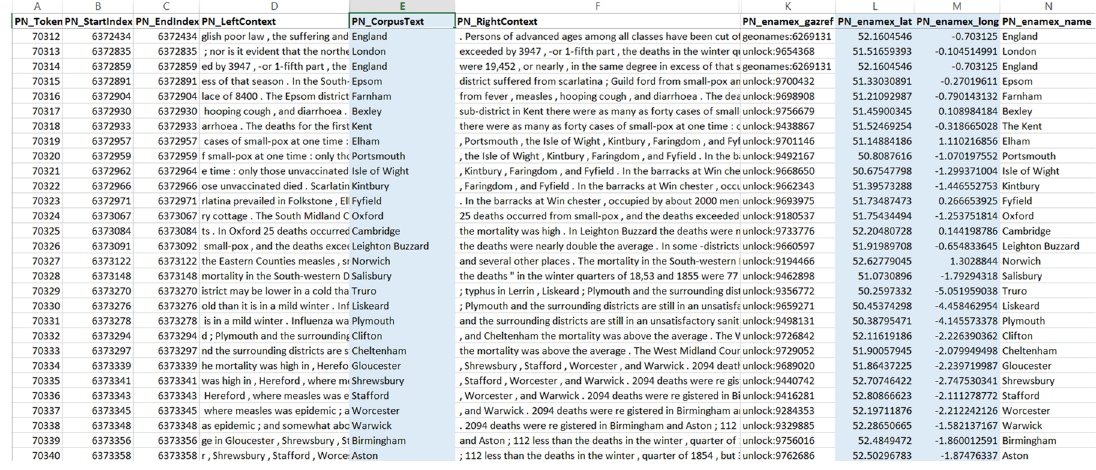
Figure 3: Sample of GIS-ready table created from the GCT.